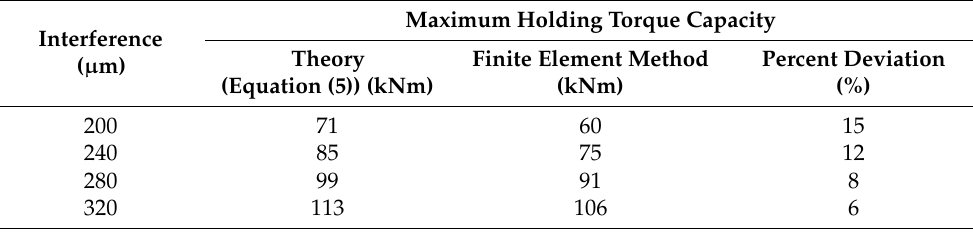
Figure 20. Torque vs rotation angle for four interferences. Table 3. Maximum holding torque capacity—theory and finite element versus